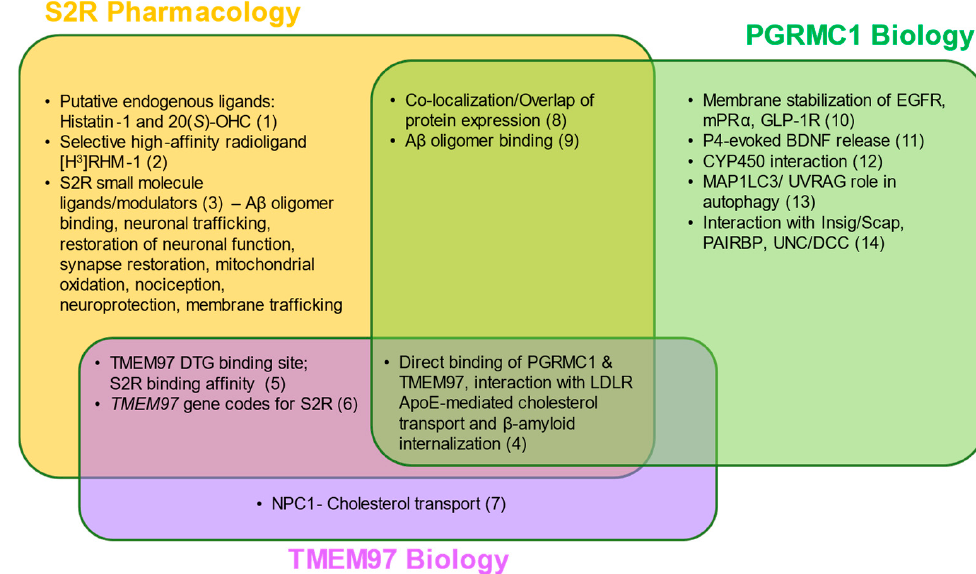
Figure 2. S2R pharmacology and the overlap with TMEM97 and PGRMC1 biology. Two putative endogenous ligands for S2R have been identified, although additional studies are needed to elucidate their roles under physiological and pathophysiological contexts. Despite this, several synthetic S2R ligands have been developed and used to investigate S2R function. Direct protein–protein interactions and functions of TMEM97 remain to be fully characterized; however, TMEM97 interacts directly with Niemann–Pick protein C1, as well as PGRMC1 and LDLR. PGRMC1 is more well-identified as a hormone receptor with multiple functions, including regulation of signal transduction pathways, protein–protein interactions, membrane trafficking, and autophagy. While ongoing studies attempt to elucidate the functions of each protein, S2R, TMEM97, and PGRMC1 converge in co-localization/co-expression and their regulation of amyloid- β binding. References: (1) [80,81]; (2) [82]; (3) [5,63,67,73,83–90]; (4) [62,66]; (5) [51,91,92]; (6) [16,61]; (7) [61,93,94]; (8) [1,59,95]; (9) [2,3,96]; (10) [97–99]; (11) [100]; (12) [78]; (13) [101,102]; (14) [103–106] Abbreviations: A β , amyloid- β ; Apo-E, apolipoprotein-E; BDNF, brain-derived neurotrophic factor; DTG, di-o- tolylguanidine; EGFR, epidermal growth factor receptor; GLP-1R, glucagon-like peptide-1 receptor; Insig/Scap, insulin-induced gene/sterol regulatory element-binding protein cleavage-activating protein; LDLR, low-density lipoprotein receptor; MAP1LC3/UVRAG, microtubule-associated proteins 1A/1B light chain 3/UV radiation resistance associated gene protein; mPR α , membrane progesterone receptor alpha; NPC1, Niemann–Pick protein C1; PAIRBP, plasminogen activator inhibitor 1 mRNA-binding protein; PGRMC1, progesterone receptor membrane component 1; S2R, sigma-2 receptor; TMEM97, transmembrane protein 97; UNC/DCC, UNC-40/Deleted in Colorectal Cancer. 5.3. Putatitve Endogenous Ligands Until recently, the endogenous ligand of S2R was unknown, although some ligands had been historically proposed but lacked conclusive substantiation in follow-on studies [107,108]. In 2021, two studies were published that identi fi ed two putative endogenous ligands of S2R: histatin-1 [80] and the oxysterol 20( S )-OHC [81]. Histatin-1 is a salivary protein with antibacterial and antifungal activities and is known to be involved in wound healing [109,110]. Histatin-1 is also found in human tears [111], and the functional binding of histatin-1 to S2R was con fi rmed in human corneal epithelial cells [80]. Because histatin- 1 expression is highly enriched in, and fairly limited to, salivary glands [1,6] and tears, further research is needed to clarify if histatin-1 is a ligand in the majority of tissues where S2R is expressed, including the brain and retina [81]. In contrast, the biology of 20( S )-OHC alone makes it a notable candidate. First, 20( S )-OHC is involved in Niemann–Pick C1 (NPC1)-mediated cholesterol homeostasis, including lipid membrane and sphingolipid metabolism [81]. Further, it is known that TMEM97 and NPC1 physically interact [94] and oxysterols are known to post-translationally enhance the activity of enzymes involved in